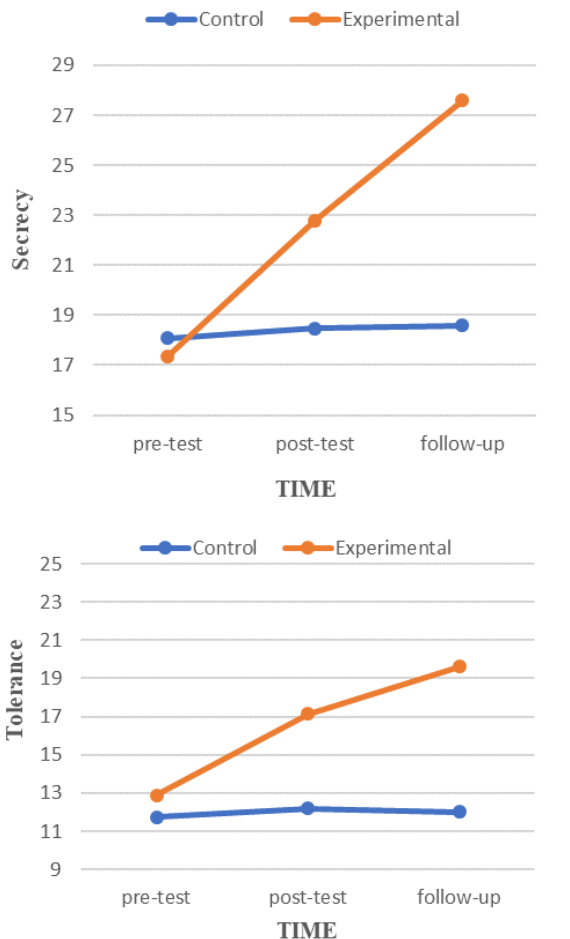
Figure 3. Mean scores of secrecy and tolerance in mothers with cerebral palsy in intervention and control